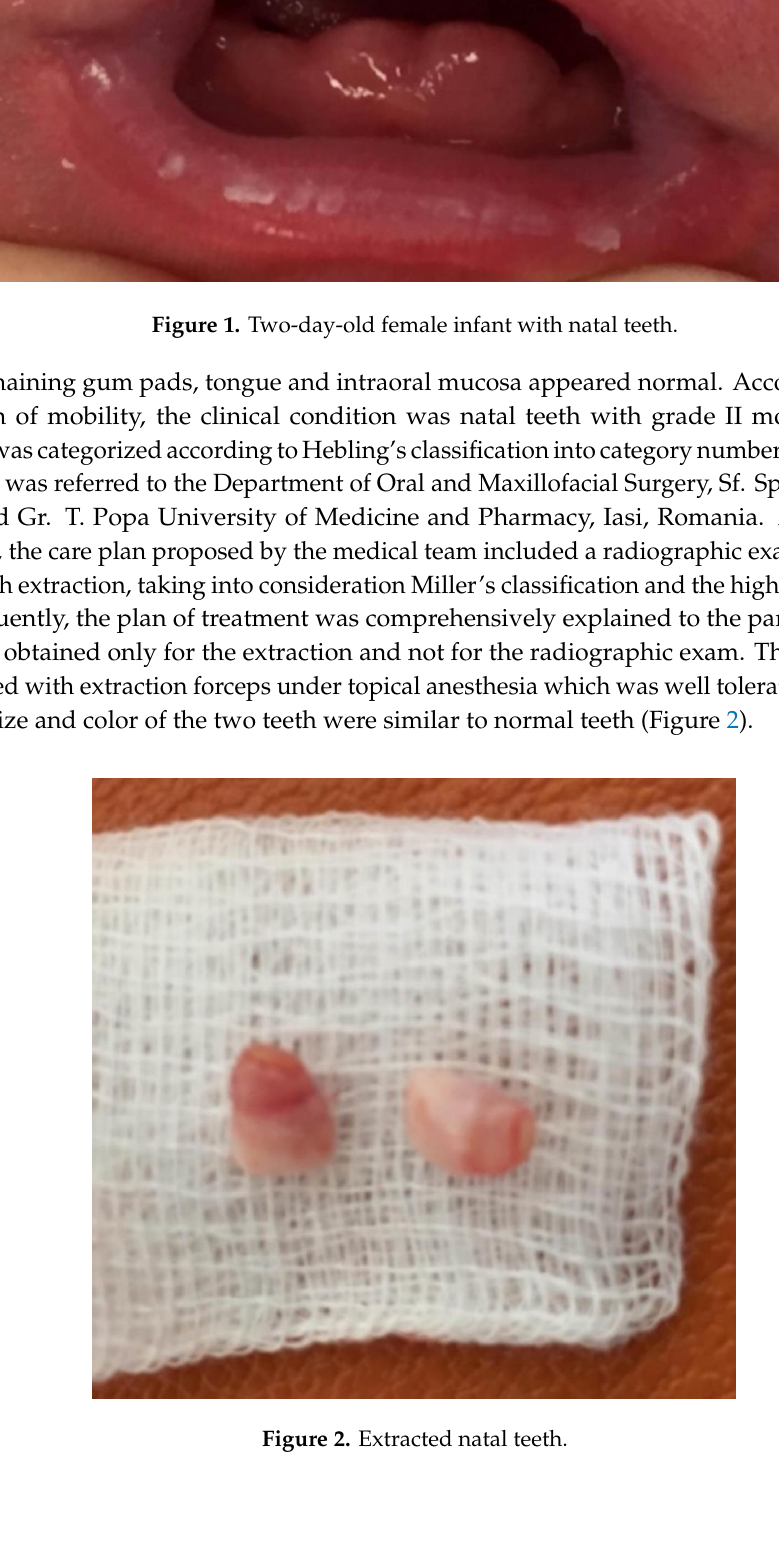
Figure 3. Postoperative site.